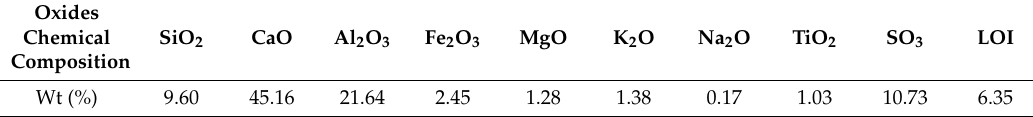
Table 2. Chemical composition of sulfoaluminate cement